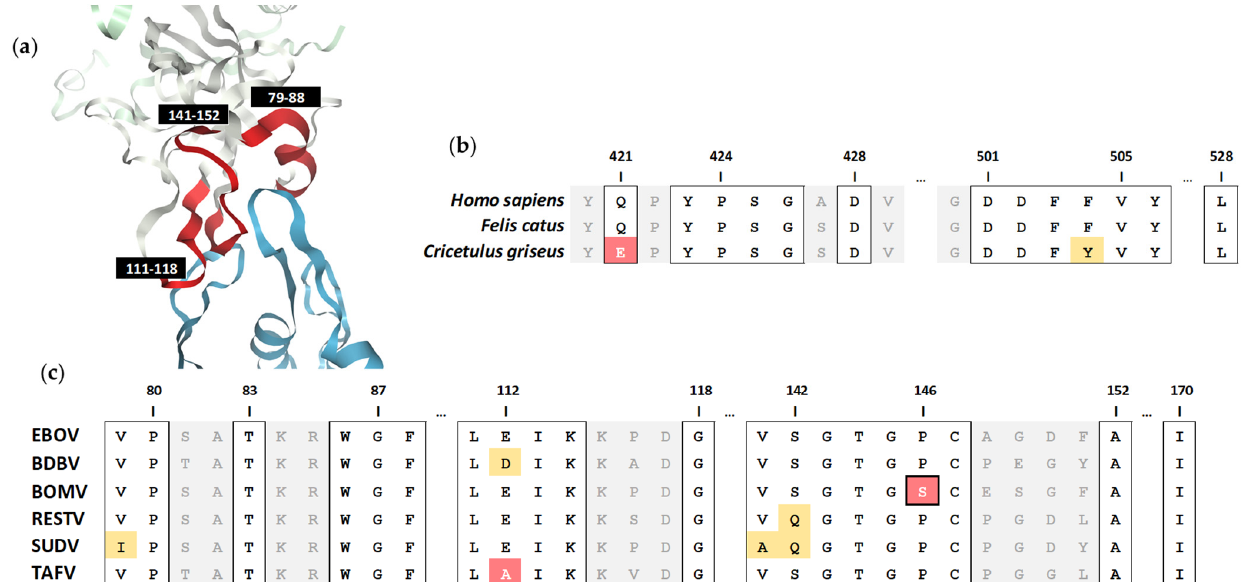
Figure 3. Analysis of NPC1 receptor binding to the ebolavirus glycoprotein. ( a ) The structure of human NPC1 receptor (blue) in complex with the EBOV glycoprotein (white) which highlights three NPC1-interacting regions (red) covering glycoprotein amino acids 79–88, 111–118 and 141–152. Alignment of the interface of ( b ) NPC1 sequence from HEK293T/17 ( Homo sapiens ), CRFK ( Felis catus ) and CHO-K1 ( Cricetulus griseus ) cell lines and ( c ) ebolavirus glycoprotein sequences, with residues in direct contact highlighted in squared boxes. Virus-specific polymorphisms are shaded yellow and red for amino acids similar or dissimilar to the consensus, respectively. The BOMV glycoprotein proline (P) to serine (S) polymorphism (P146S) is outlined.